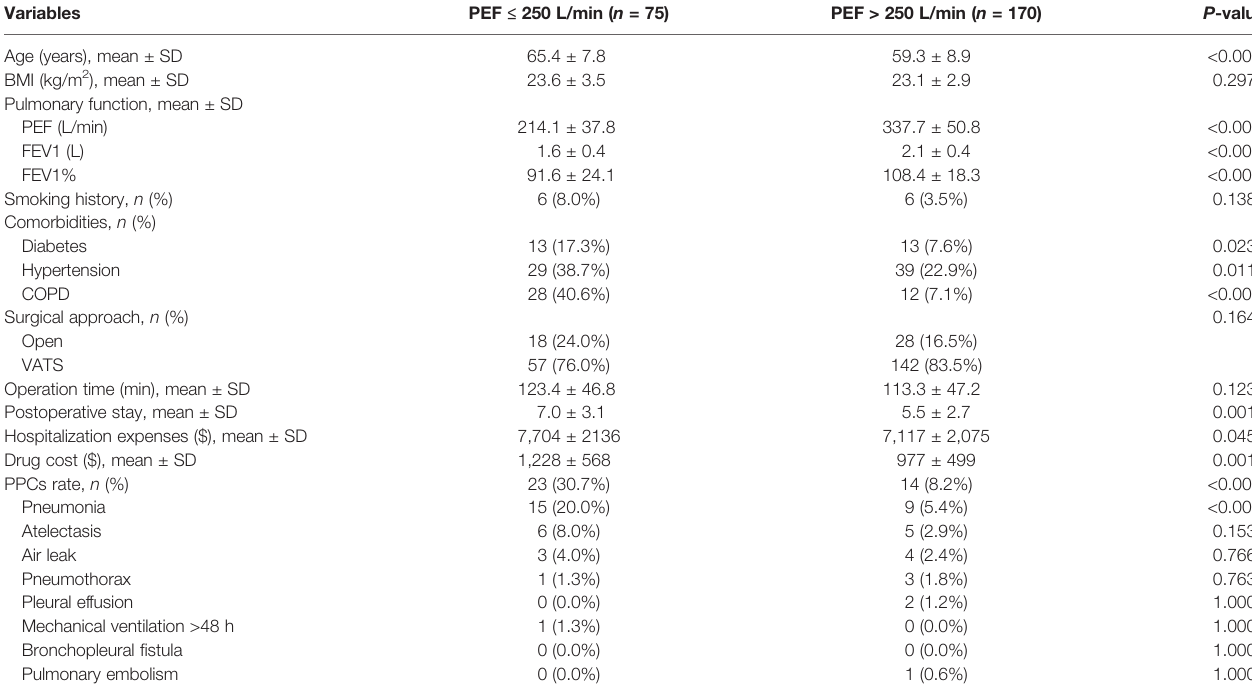
TABLE 3 | Clinical characteristics and outcomes between female patients divided by cutoff value of PEF.